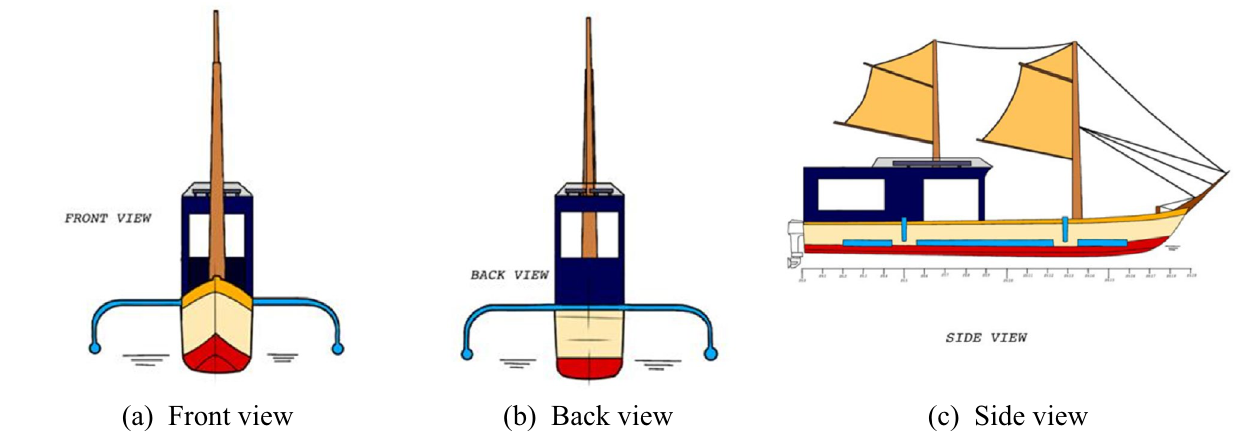
Fig. 2 Small boat design with long mast and tent cover. a front view; b back view; c side